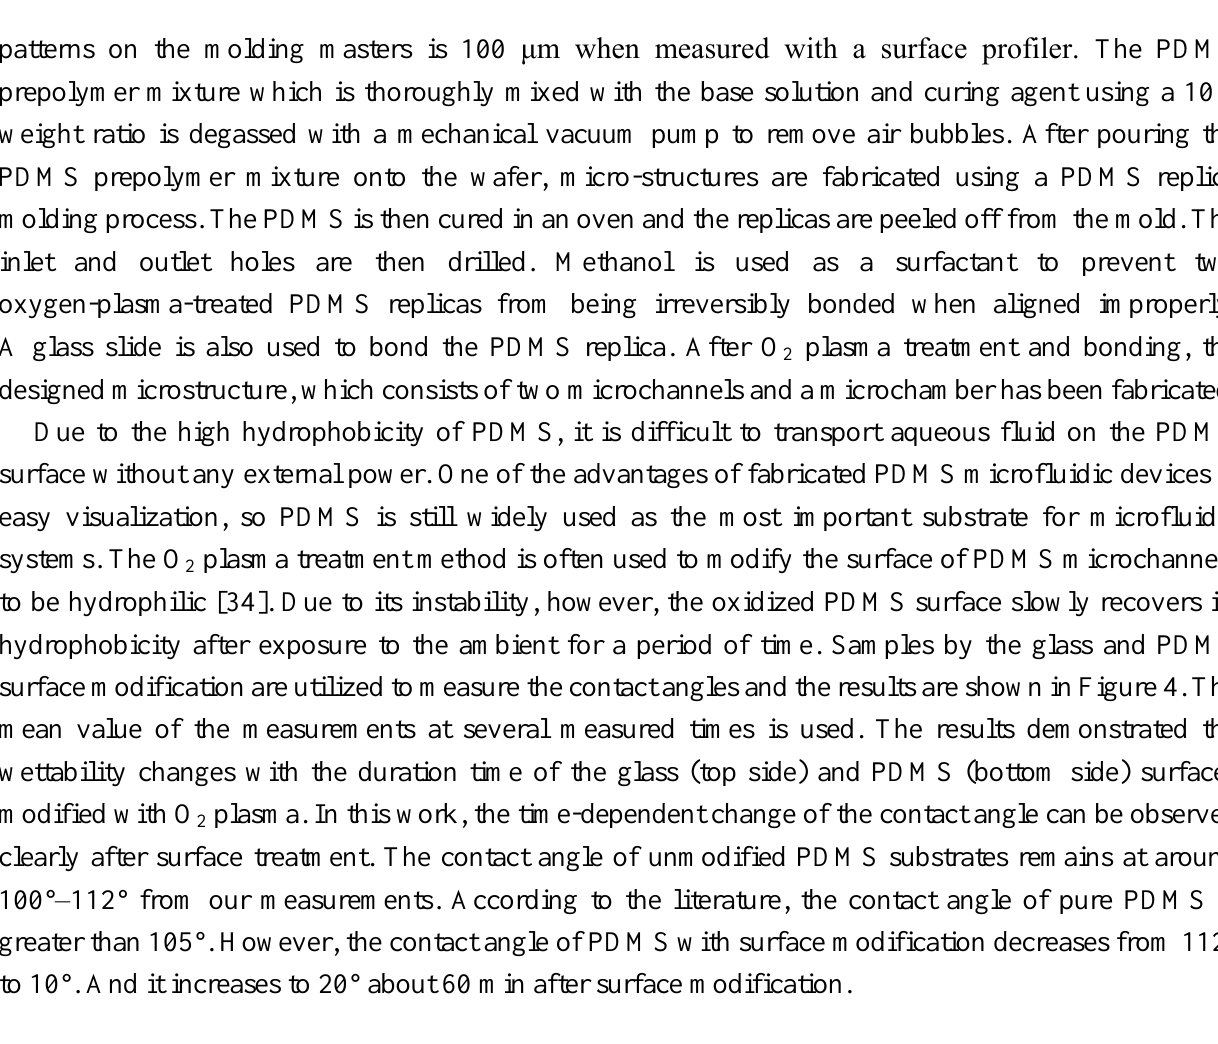
Figure 4. The measurement of the static contact angle of water on the surface-modified PDMS